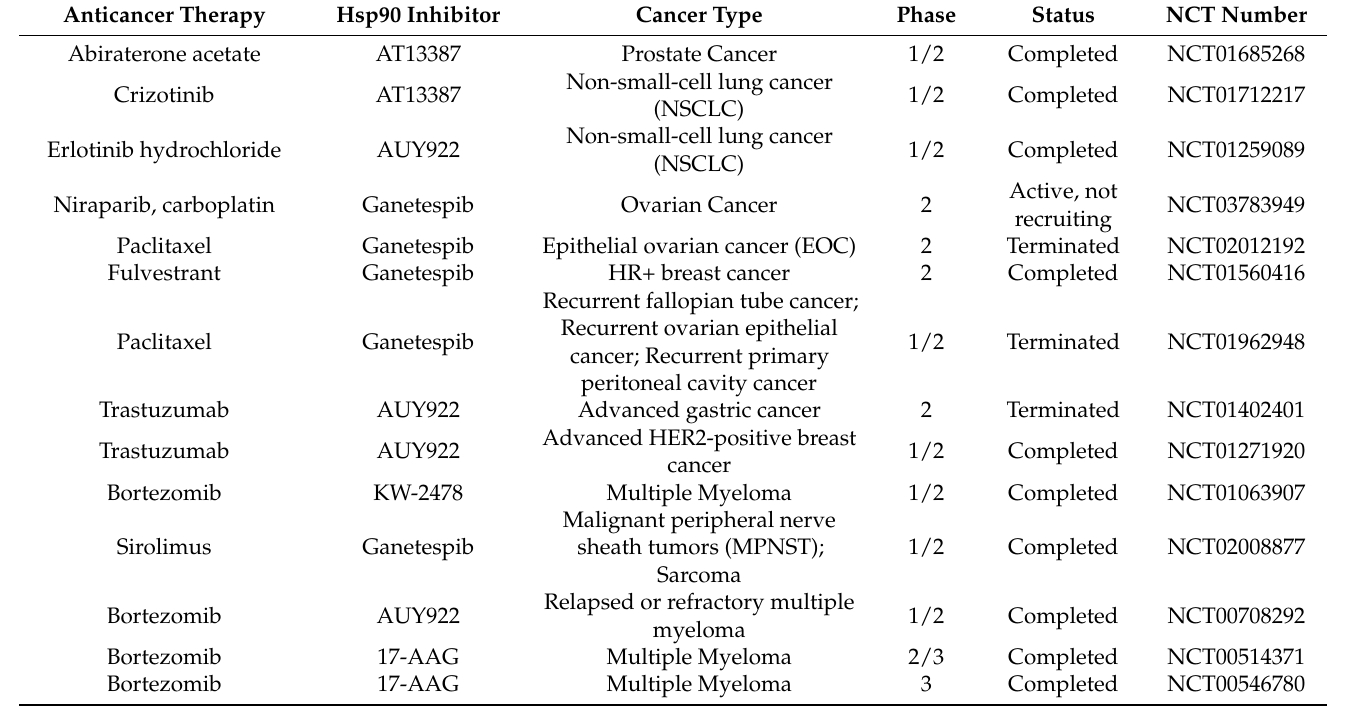
Table 3. Overview of HSP90 inhibitors combination therapy in clinical trial